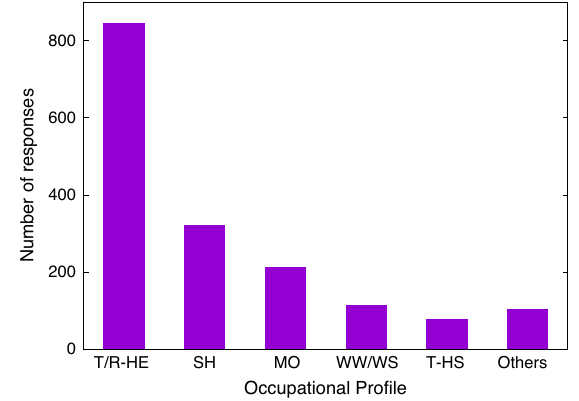
FIG. 7. Distribution of occupation of the respondents. The initials in the abscissa axis correspond to the following catego- ries: lecturers and/or researchers in higher education institutions (T/R-HE), scholarship holders (SH), multiple occupations (MO), without work nor scholarship (WW/WS), high school teachers